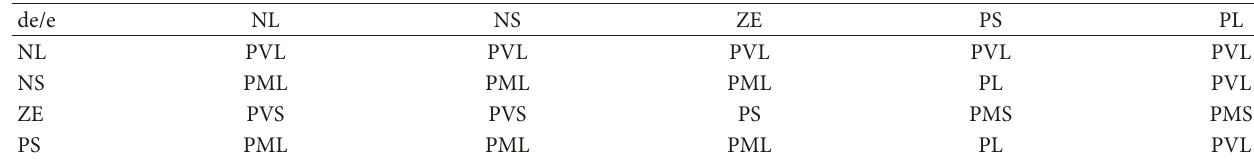
Table 2: Fuzzy rule for 𝑘 𝑝 .